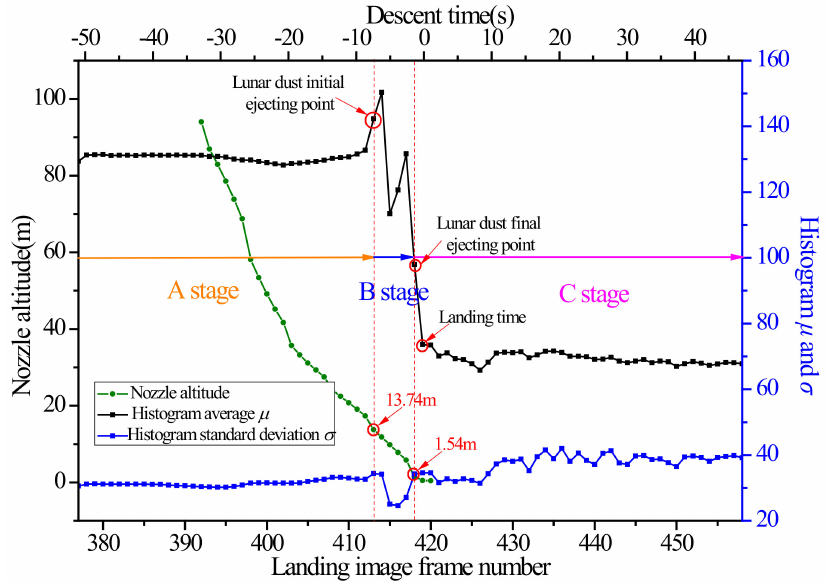
Figure 4. Histogram parameters and nozzle altitude information from landing photos of the Chang’E- 5